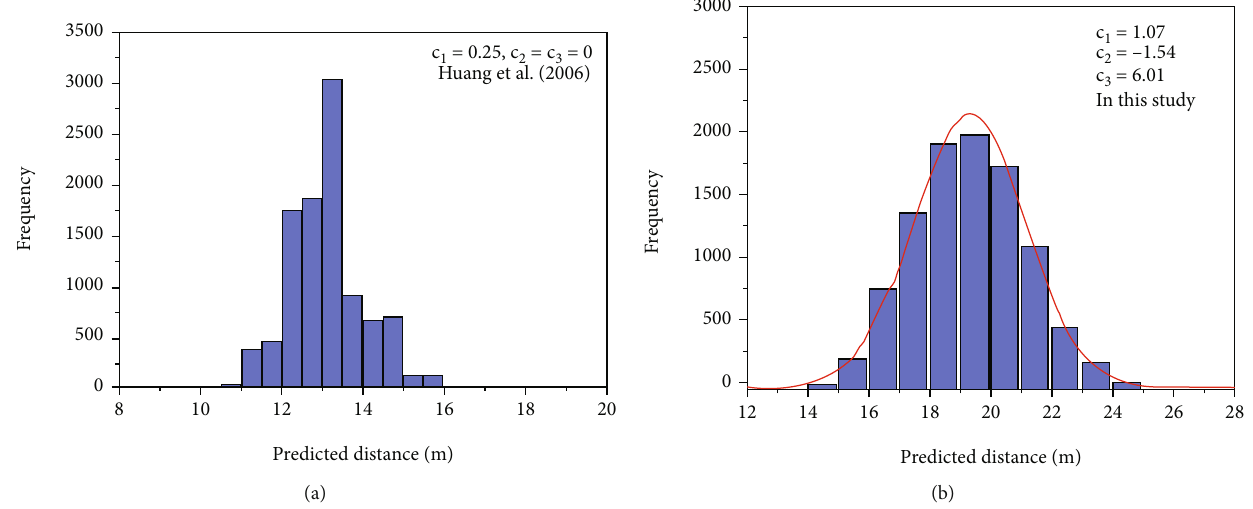
Figure 12: The distribution of prediction results for 10,000 random models at the real distance d = 20m by the prediction equations. (a) Equation was proposed in Huang et al. (2006). (b) This study. Here, the mean μ = 19 : 34 and standard deviation σ = 1 : 86 .